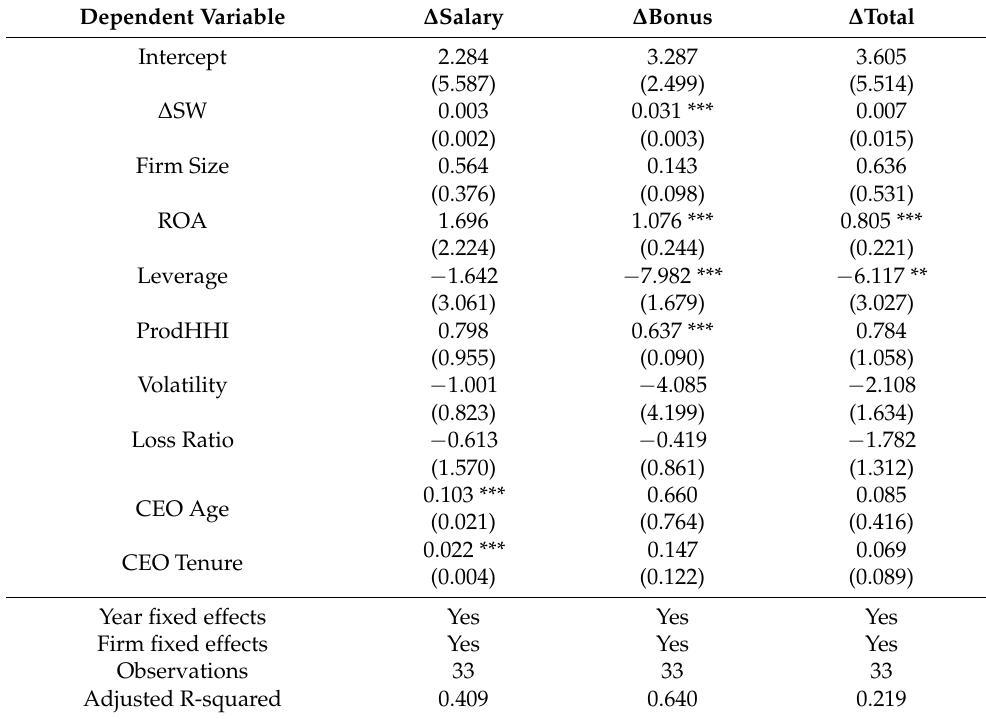
Table 4. CEO Compensation-Performance Sensitivity (Korean Non-life Insurance Firms) using the Bootstrap